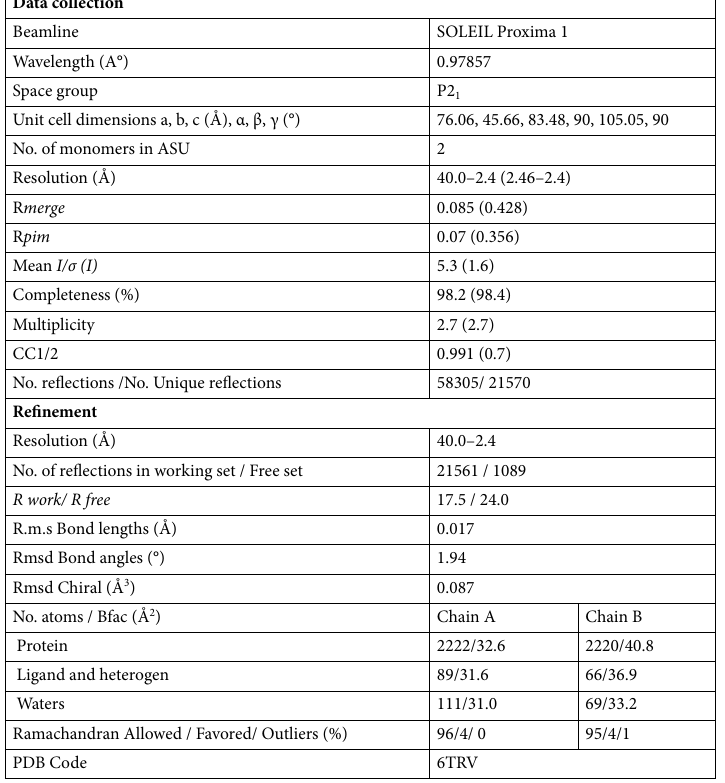
Table 1. Data-collection and refinement statistics *Values in parentheses are for the outer shell.